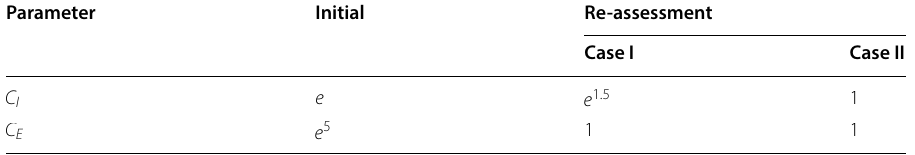
Table 4 Pattern measure constants of Step 2 Parameter Initial